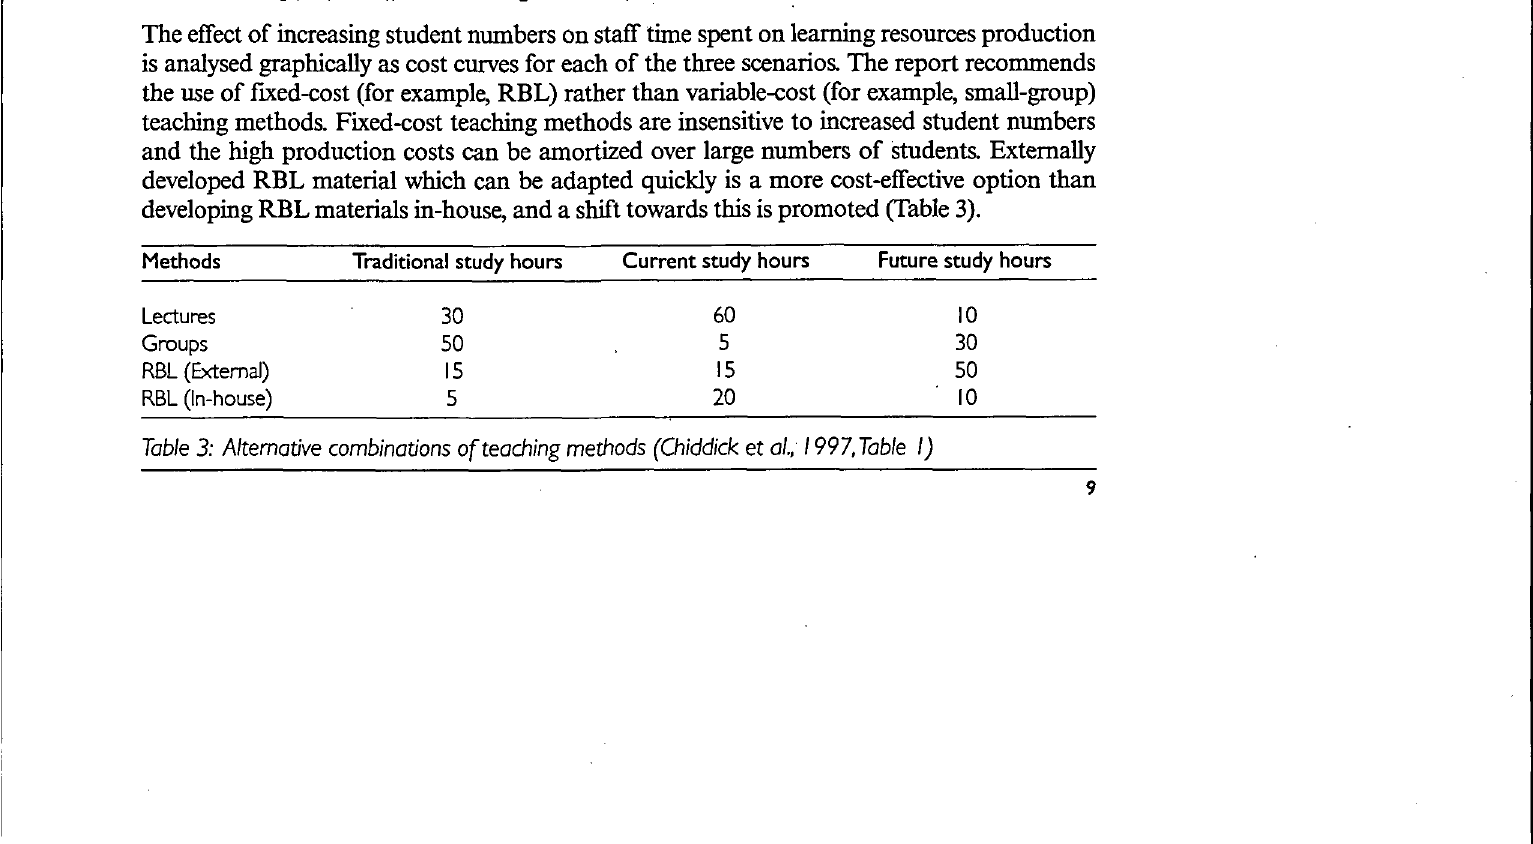
Table 2: Assumptions of preparation and presentation staff time required to produce one hour of student learning for four different teaching methods (Chiddick et al., 1997)